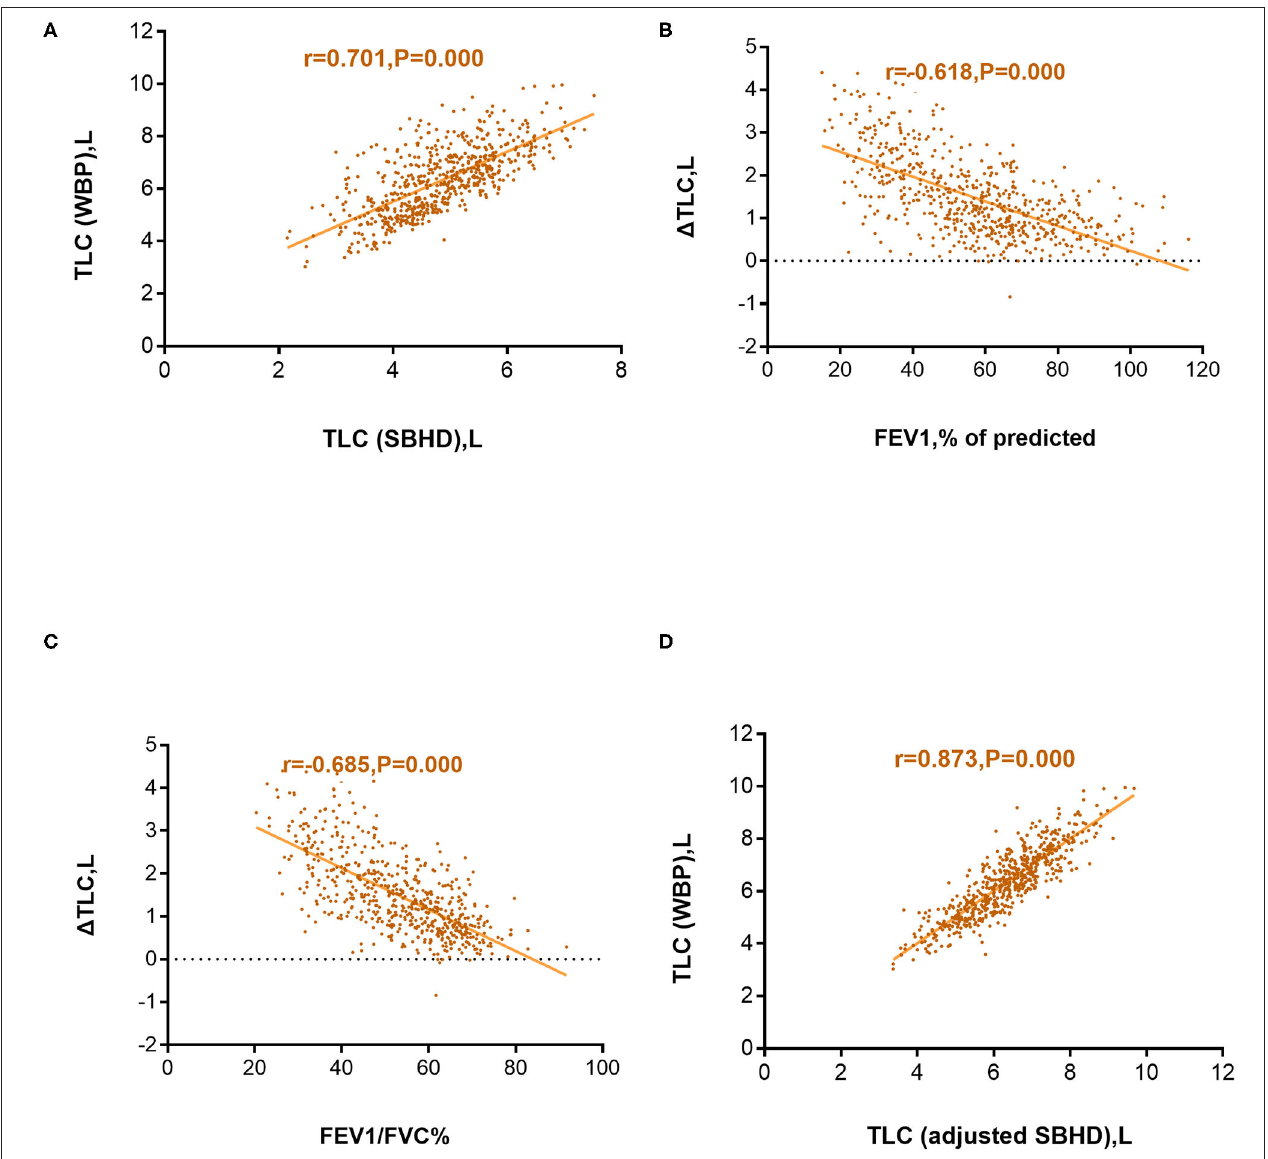
FIGURE 2 | Correlation between the total lung capacity determined by whole-body plethysmography [TLC (WBP)] and total lung capacity determined using the single-breath helium dilution method [TLC (SBHD)] (A) ; Correlation between the difference in TLC (WBP) and TLC (SBHD) ( 1 TLC) and predicted forced expiratory volume in 1s (FEV1%pred) (B) ; Correlation between 1 TLC and FEV1/forced vital capacity (FVC%) (C) ; Correlation between TLC (WBP) and TLC (adjusted SBHD) (D)